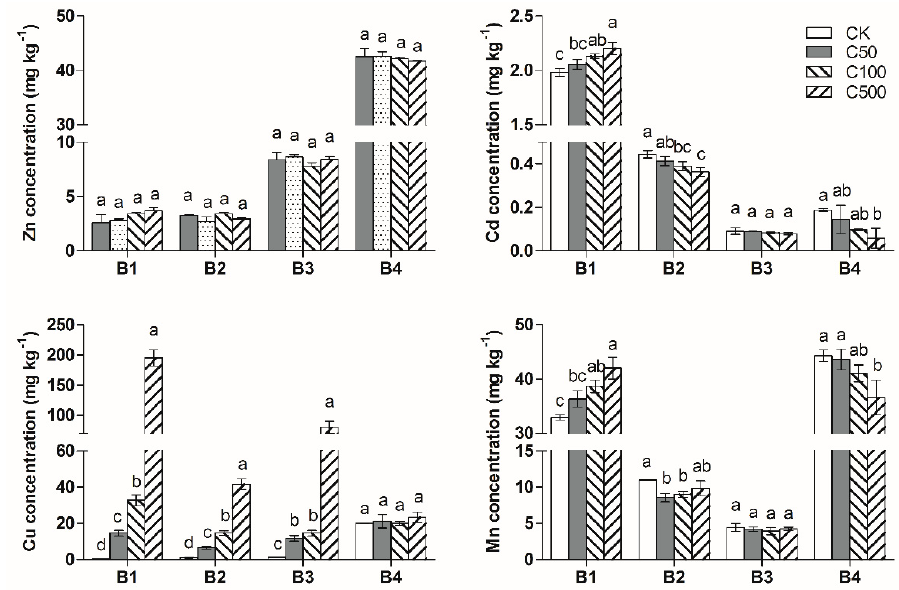
Figure 4. Changes in soil heavy metals chemical speciation with CuO-NPs addition. B1: acid-soluble fraction; B2: Fe/Mn oxides-bound fraction; B3: organic-bound fraction; B4: residual fraction. Different letters above each column indicate significant difference ( p < 0.05) between various treatments.